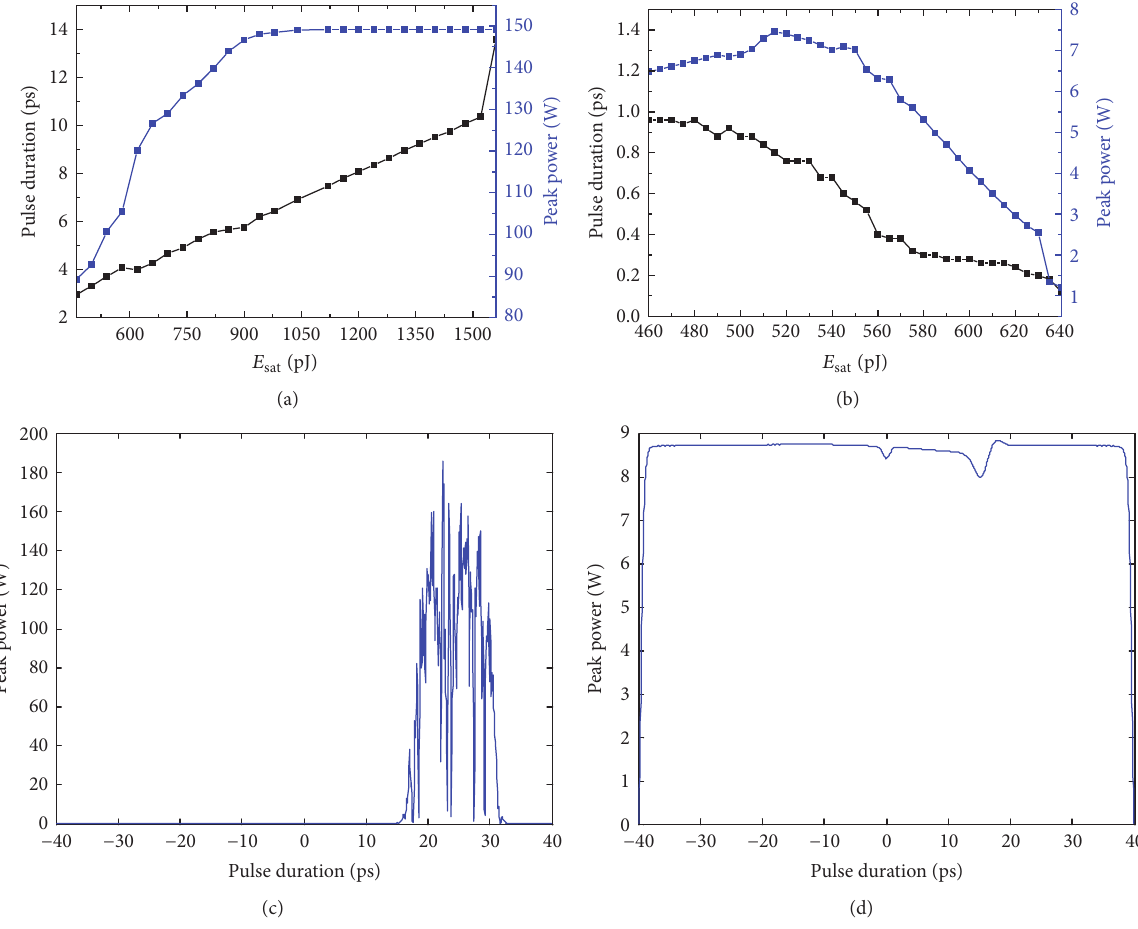
Figure 4: (a) With the increase of 𝐸 sat , dissipative soliton pulse duration and peak power change. (b) With the increase of 𝐸 sat , dark soliton pulse duration and peak power change. (c) Temporal profile of the dissipative soliton at 𝐸 sat = 1560 pJ. (d) Temporal profile of the dark soliton at 𝐸 sat = 640